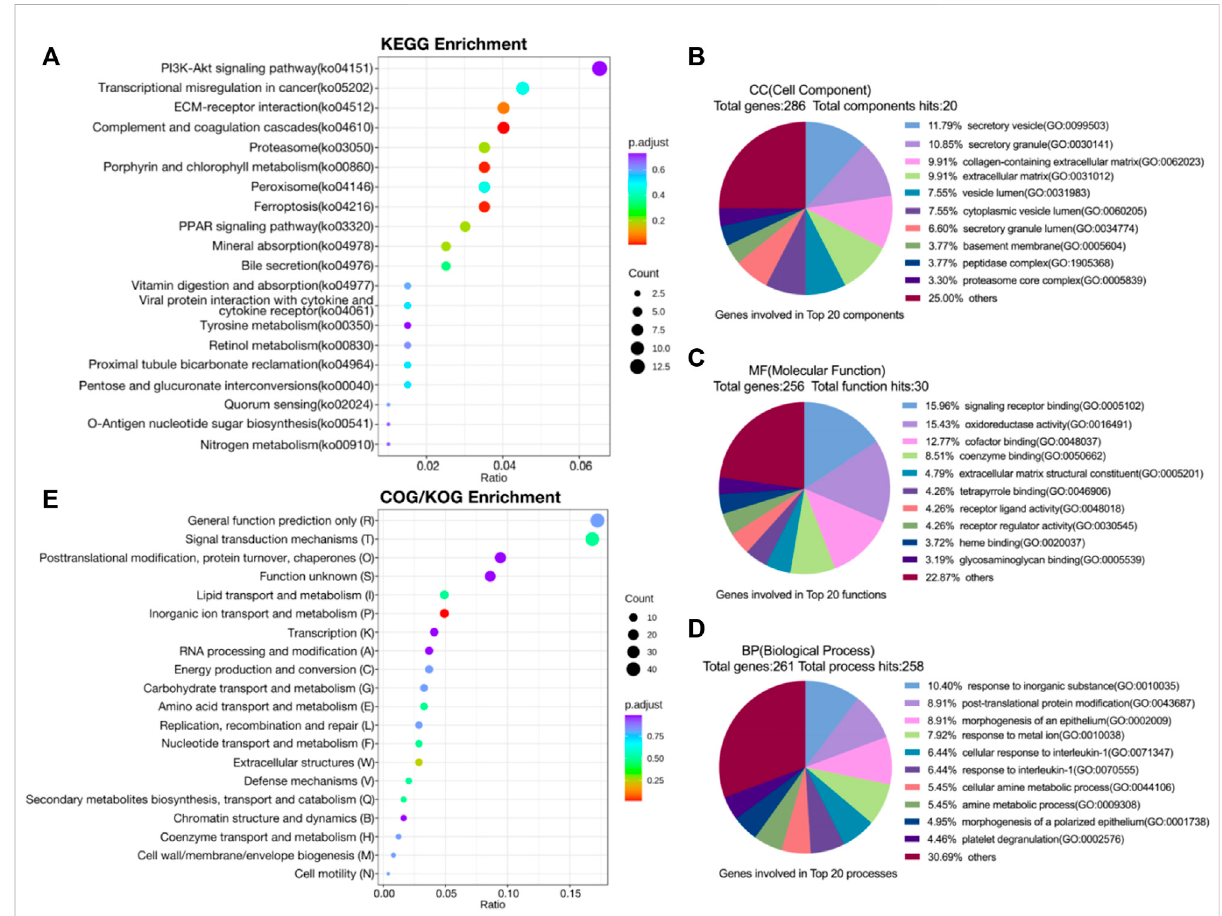
FIGURE 2 Proteomic analysis of SLC39A1-Overexpressed OSRC-2 cells. (A) KEGG pathway analysis of proteomic data. (B – D) Gene Ontology analysis of DEGs. (B) Biological Process (BP) category, (C) Molecular Function (MF) category and (D) Cellular Component (CC) category. (E) COG/KOG enrichment analysis of proteomic